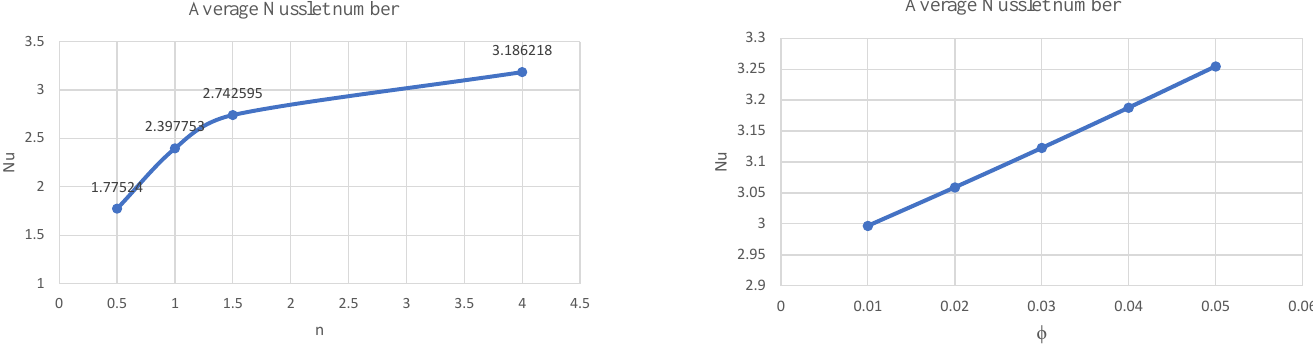
Figure 7. The average Nusselt number below the influences of n and φ . The impacts of inner superellipse shape on vertical velocities and temperature profiles are shown in Figure 8. Overall, increasing the area of the inner shape obviously raised the temperature and slightly raised the vertical